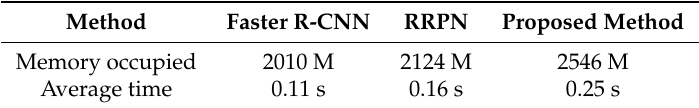
Table 3. Computational consumption of each tested model on our